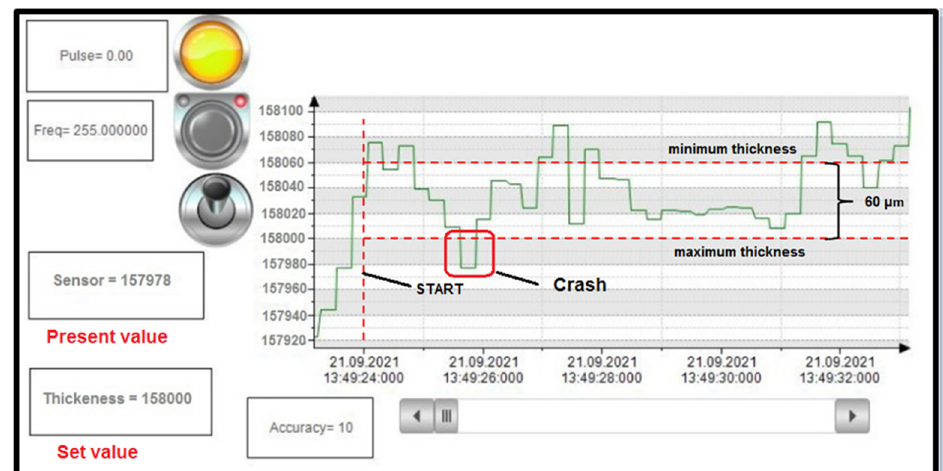
Figure 4. Panel for displaying information of the industrial controller.